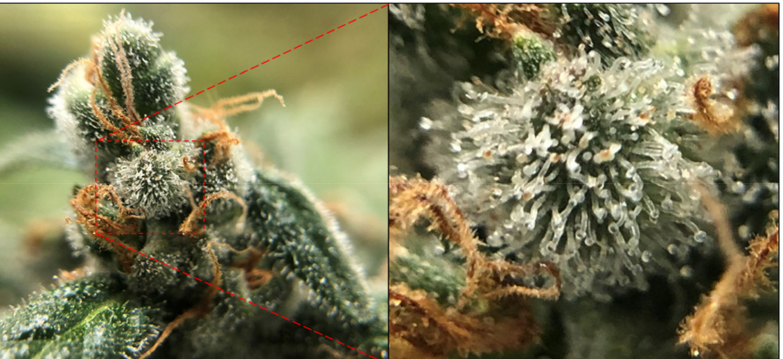
Figure 1. A close up of the female floral architecture of mature Cannabis sativa plants. The cannabinoid- containing glandular trichomes are visible in the magnified image, and are characterised by a globular head which is connected to the plant via a stalk. Colouration of the heads ranges from translucent, to a creamy white, to